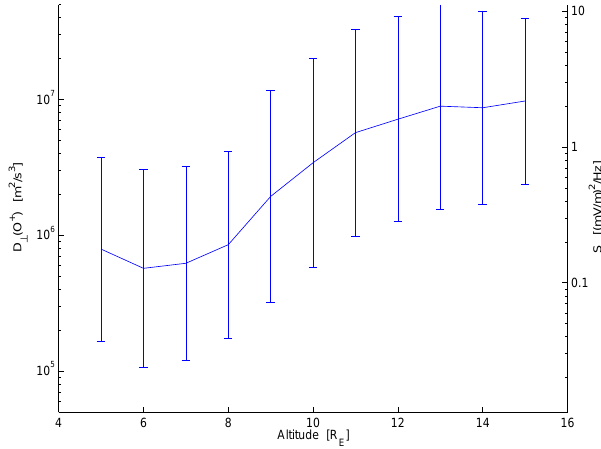
Fig. 4. Profile of the perpendicular diffusion coefficient for O + . The blue error bars show the standard deviation for the logarithmic value. The right axis is the values for diffusion coefficient and the left axis shows the corresponding electric field spectral density at the O + gyrofrequency.